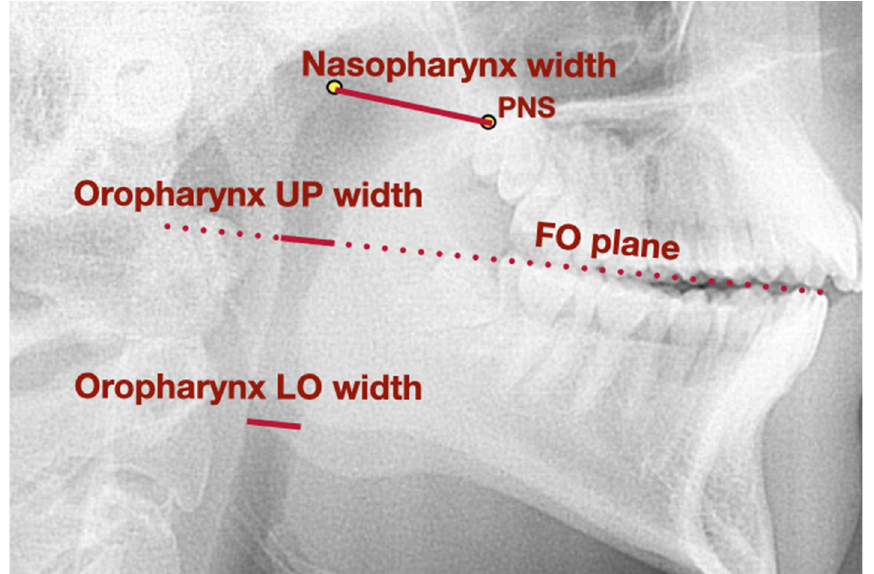
Figure 2. Lateral cephalogram with marked points, lines, and angles presented in Table 1 used to assess airways dimension. FO plane—functional occlusal plane, LO—lower, PNS—posterior nasal spine, UP—upper.